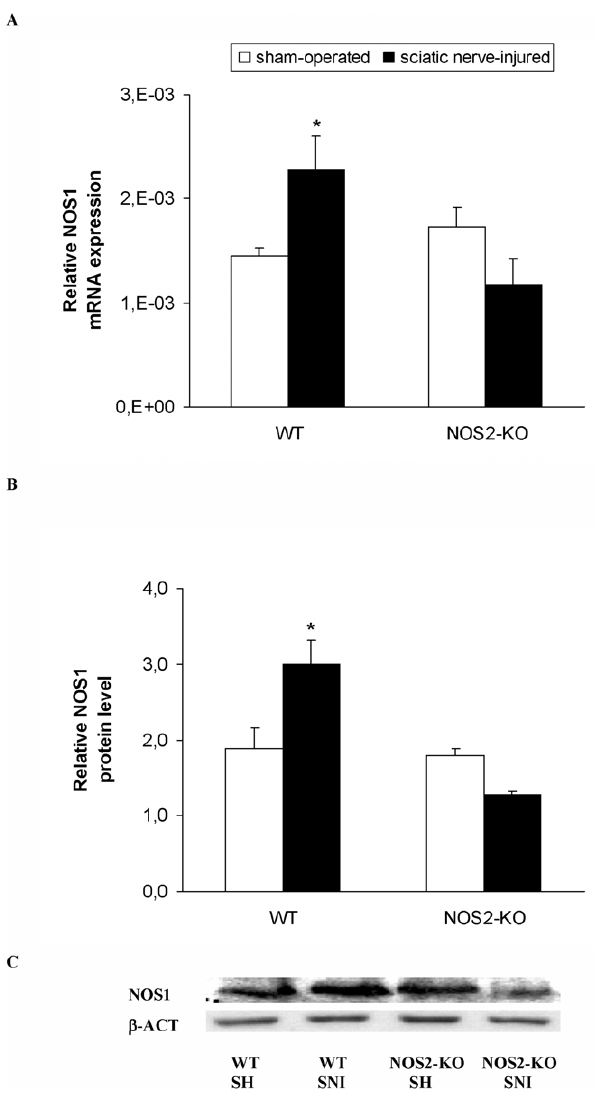
Figure 2. Spinal cord expression of NOS1 in WT and NOS2-KO mice. The relative NOS1 mRNA ( A ) and protein ( B ) expression in the ipsilateral site of the lumbar section of the spinal cord from sham- operated (SH) and sciatic nerve-injured (SNI) WT and NOS2-KO mice at 21 days after sciatic nerve ligation are represented. In both figures, * indicates significant differences when compared sciatic nerve-injured WT mice vs. sham-operated WT animals (* p , 0.05, one-way ANOVA followed by Student-Newman-Keuls test). A representative example of Western blots for NOS1 protein (155 kDa) in which b -actin (43 kDa) was used as a loading control is shown in C . Data are expressed as mean values 6 SEM; n=4–5 samples per group.